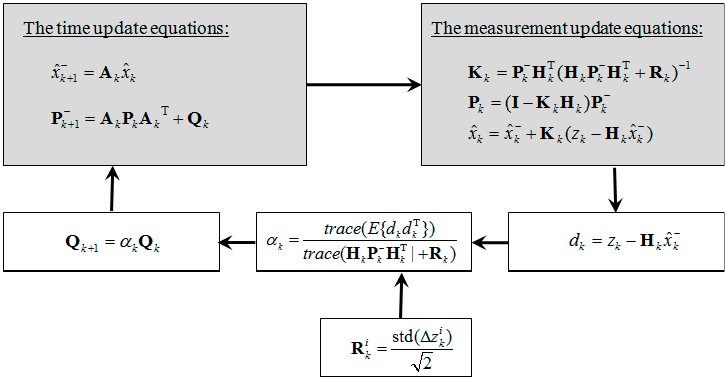
Figure 3. Schematic diagram of the Kalman filtering.